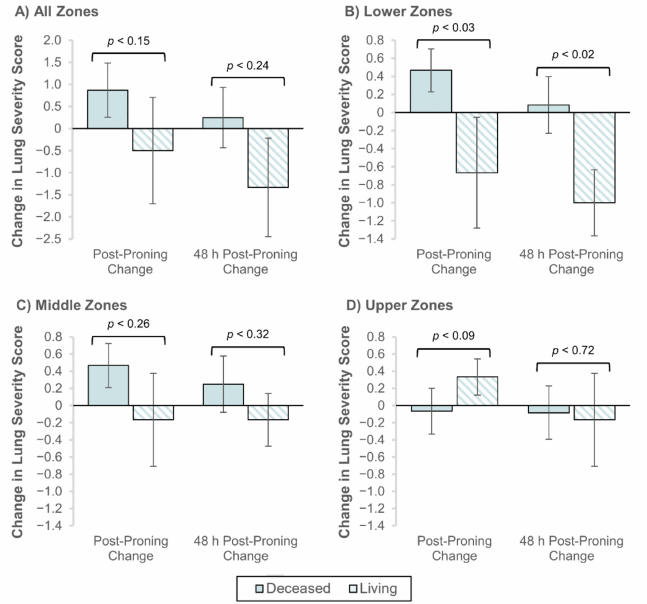
Figure 6. Change in lung severity scores immediately and 48 hours (h) post-proning by living status. Thechangefrombaselineinlungseverityscorewasmeasuredinradiographstakenimmediatelyand48h after prone ventilation. Results are shown by the following aggregate lung zones: ( A ) all 6 lung zones, ( B ) lower lung zones, ( C ) middle zones, and ( D ) upper zones. Error bars represent S.E. of the mean. Statistical significance is given by the Mann-Whitney U test with α =